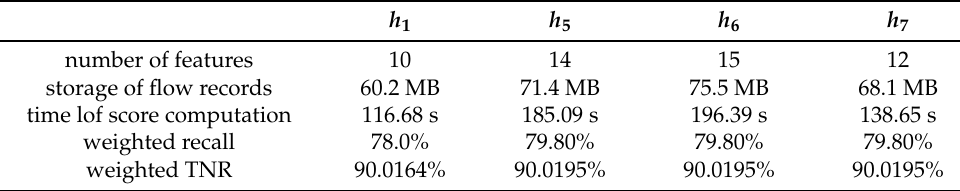
Table 8. Time and computational resources for selected bidirectional